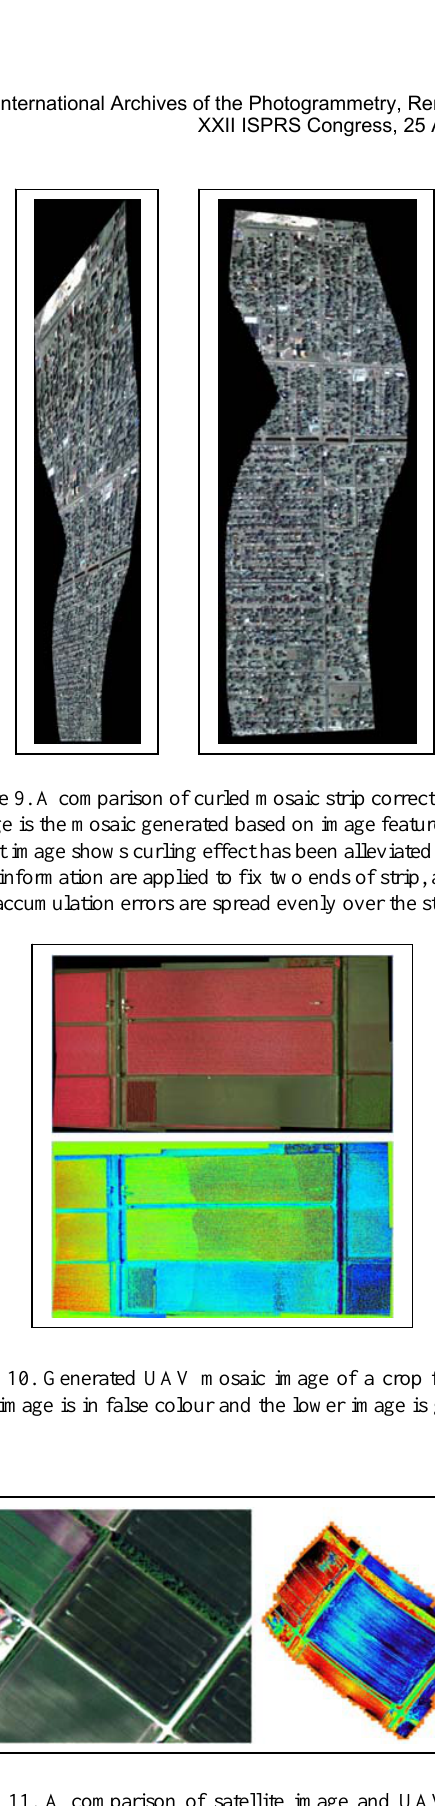
Figure 11. A comparison of satellite image and UAV mosaic image of a crop field. Left image a pansahrpen Worldview-2 ( © Digital Globe), right image is NDVI from a UAV